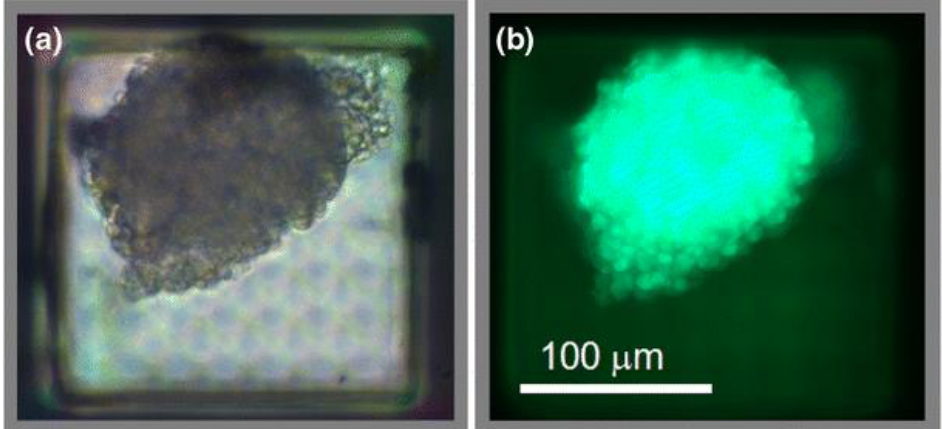
Figure 7. The transparent microcontainer was devised to facilitate optical imaging of the encapsulated cells. A representative phase contrast micrograph ( a ) and fluorescent image acquired in the green channel ( b ) of a cluster of ~3000 9L-3HRE-luc/GFP cells encapsulated within the sealed microcontainer. Reprinted from Gimi et al. [51] with permission of Springer.